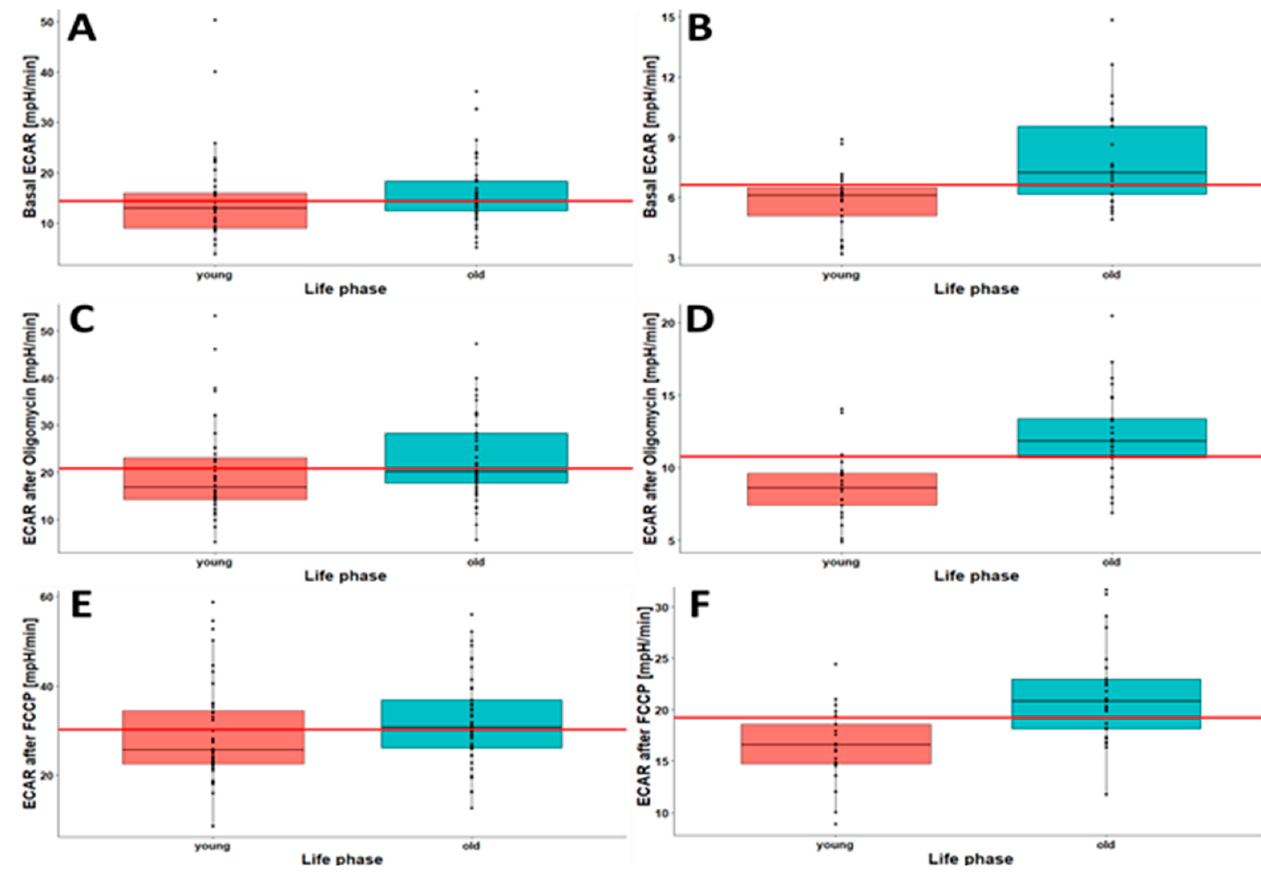
Figure 6. Boxplots of basal extracellular acidification rate (ECAR) (mpH/min) ( A , B ), ECAR oligomycin (mpH/min) ( C , D ) and maximal ECAR (FCCP) [mpH/min] ( E , F ) in young and old persons in Opti-isolated PBMCs ( A , C , E ; young n = 40, old n = 49) and Robo-isolated PBMCs ( B , D , F ; young n = 21, old n = 25). The red line indicates the median of all life phases. The median of extracellular acidification in the Robo-isolated PBMCs from young persons was lower than the median of all life phases. However, the median of extracellular acidification in old persons was always higher than the median of all life phases. Strong effects were detectable in Robo-isolated PBMCs using Cohen’s d (Table 4). Taken together, the present findings show significant differences in CSA parameters in PBMCs between life phases. Robo-isolated PBMCs showed the greatest effects, and Opti-isolated PBMCs confirmed this trend. Table 4. Mean, standard deviation and median of basal ECAR (mpH/min), ECAR oligomycin (mpH/min) and maximal ECAR (FCCP) [mpH/min] by life phase in Opti-isolated PBMCs ( n = 302) and Robo-isolated PBMCs ( n = 216) and the results of Cohen’s d analyses for the comparison of CSA parameters in young and old persons.